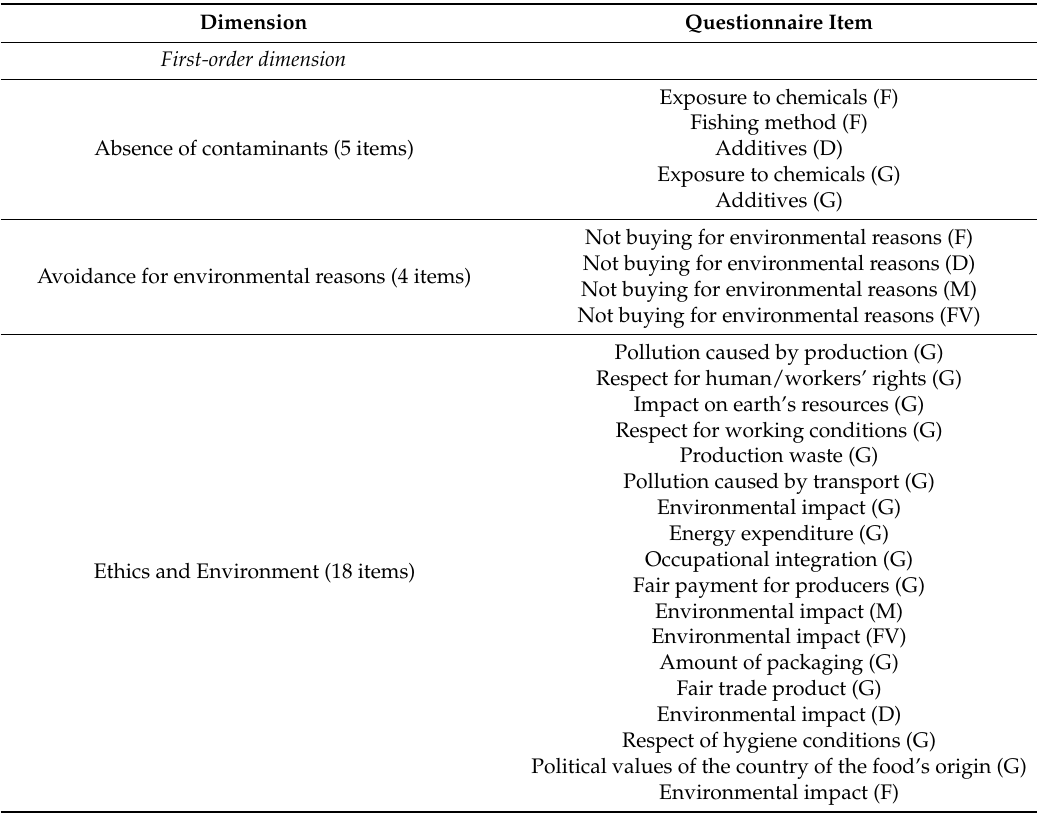
Table 1. Overview of the 63 questionnaire items included in the first- and second- order dimensions determined by factor